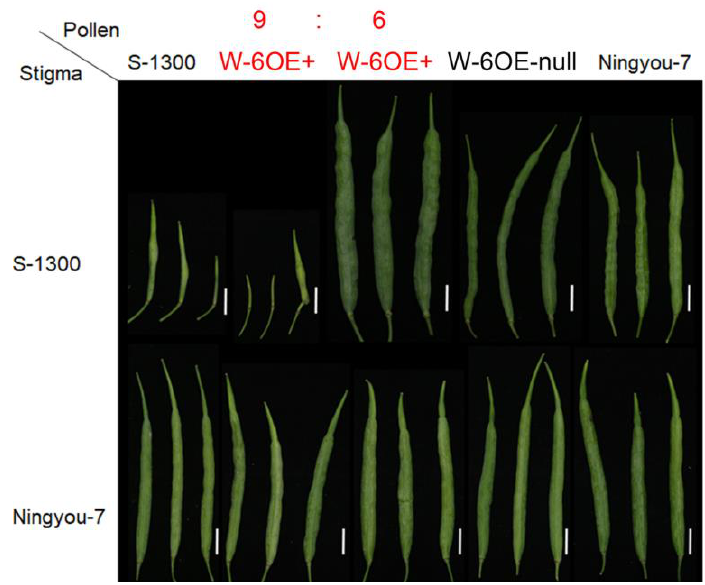
Figure 5. Pollination test of the T 3 generation of BnSCR-6 overexpression materials. W-6OE-null: genetically modified negative material; Bar = 1 cm.